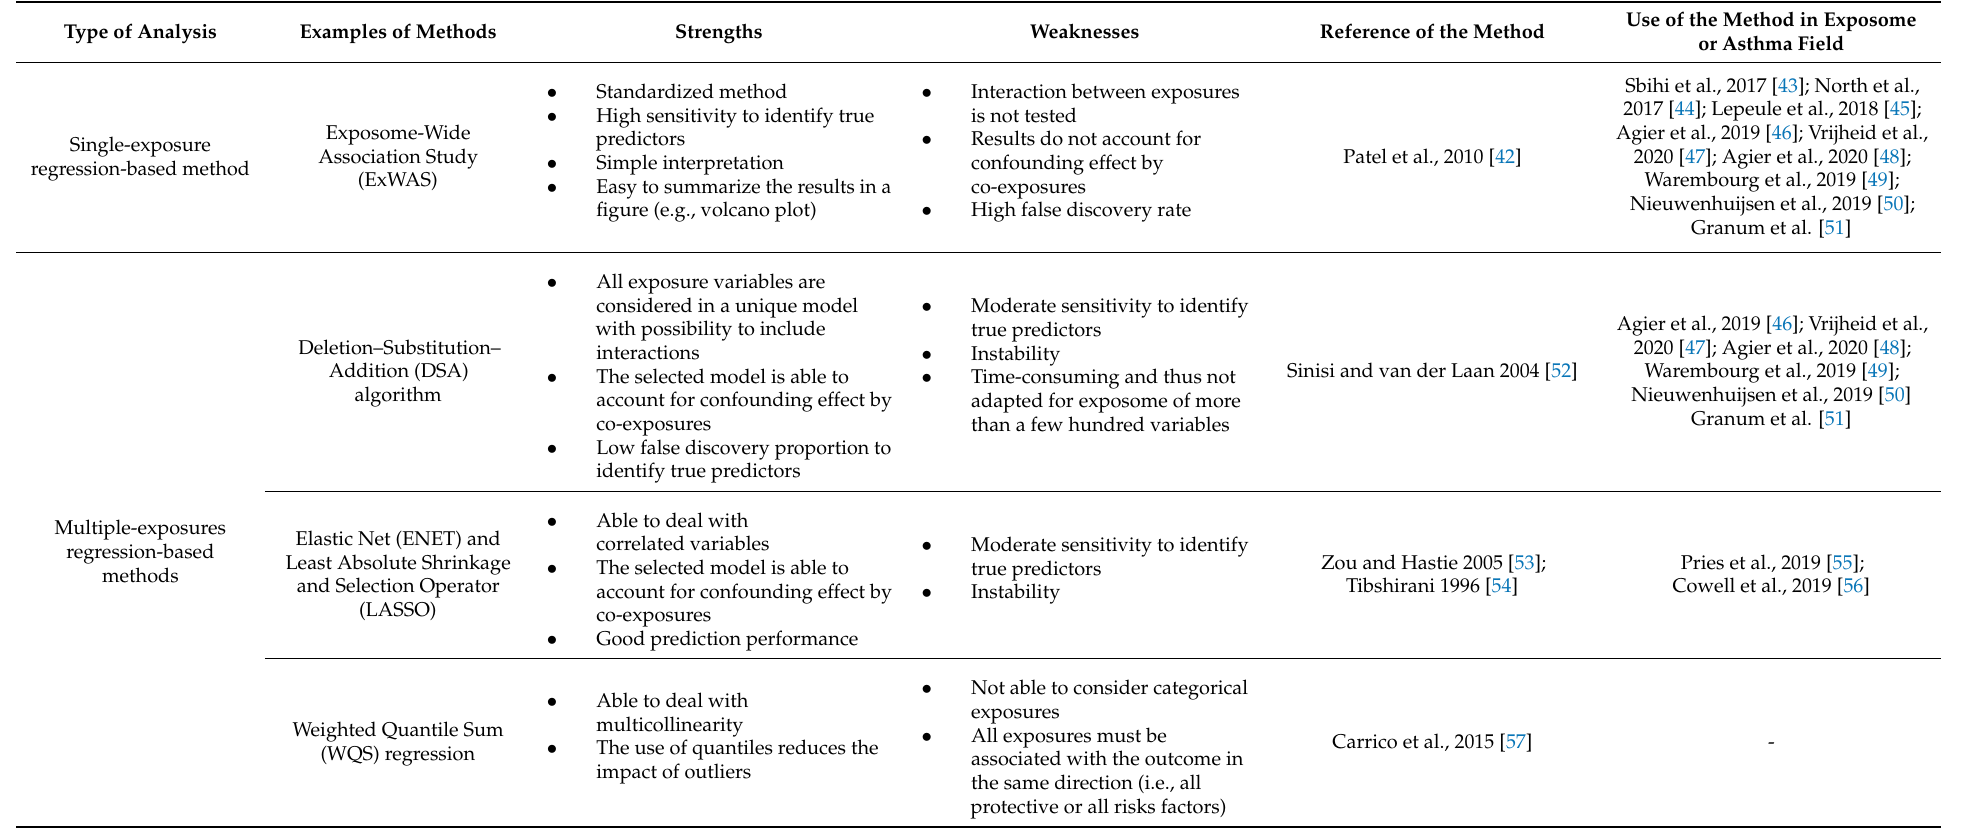
Table 1. Main statistical methods used in exposome-health association